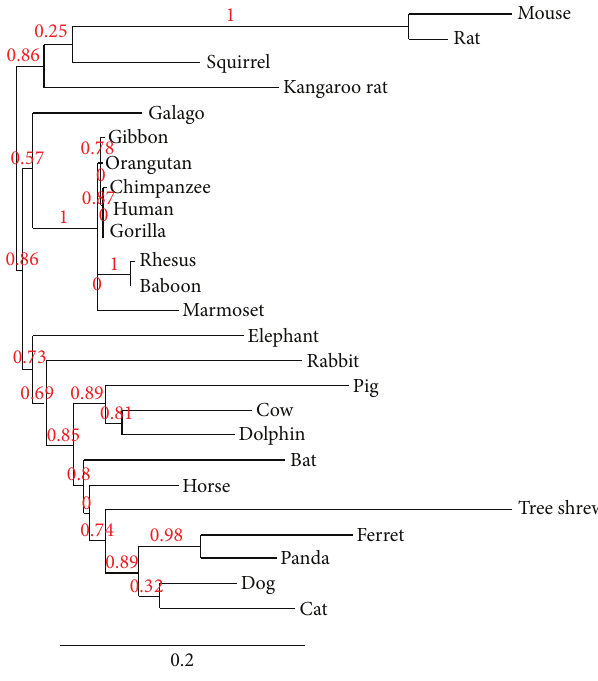
Figure 1: Best fit PLAC1 phylogeny among placental mammals based upon the coding region sequence. Maximum likelihood bootstrap support values are shown on nodes.